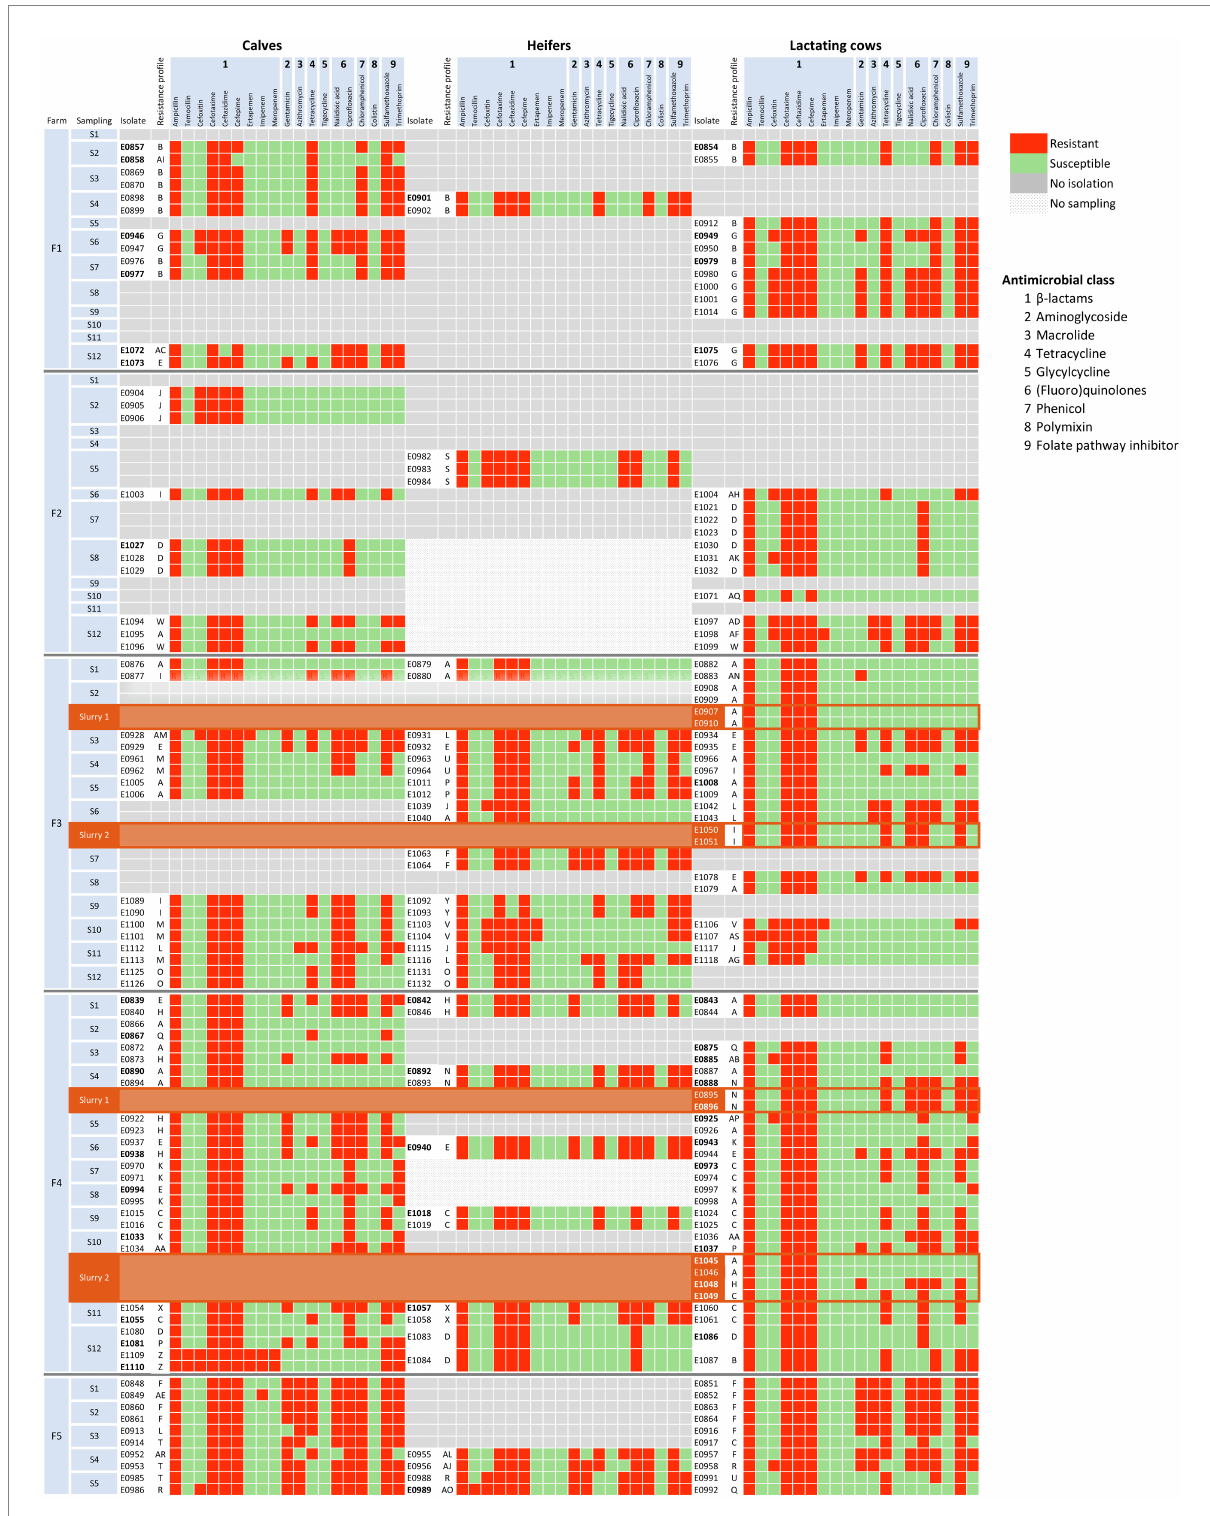
FIGURE 2 Distribution of AMR phenotypic profiles of the 197 E. coli isolates by farm, sampling, and age group. Each phenotypic profile is represented with a letter of the Latin alphabet as described in Supplementary Table S1. Antimicrobial susceptibility, determined by the broth microdilution method and interpreted using epidemiological cutoff values (see text), is shown in green for susceptible, and in red for resistant isolates. Slurry samples are indicated with a different background color (brown) and placed below lactating cows to save space. Antimicrobial classes are indicated with numbers: 1 = β -lactam, 2 = Aminoglycoside, 3 = Macrolide, 4 = Tetracycline, 5 = Glycylcycline, 6 = (Fluoro)quinolone, 7 = Phenicol, 8 = Polymyxin, 9 = Folate pathway